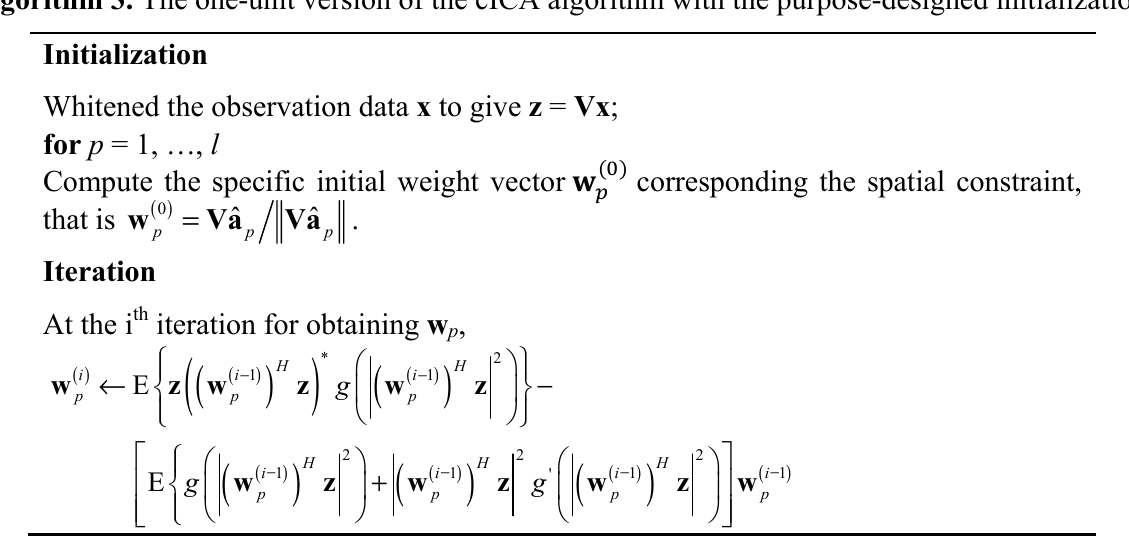
Algorithm 3. The one-unit version of the cICA algorithm with the purpose-designed